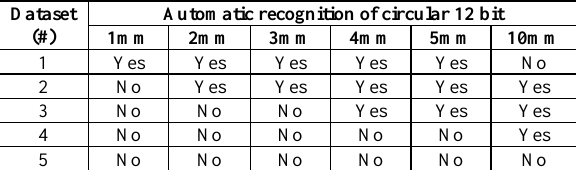
Table 5. Automatic code recognition using circular 12-bit target Dataset (#)